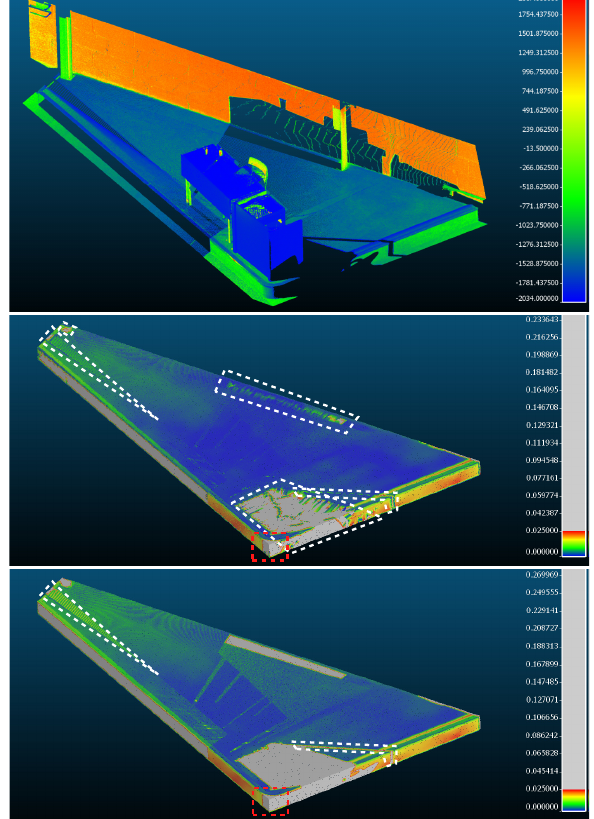
part of the points classified as occluded are actually part of a mi- nor modeling error (the front corner of the floor is modeled with a sharp edge instead of a radius fillet, see red dashed rectangle),